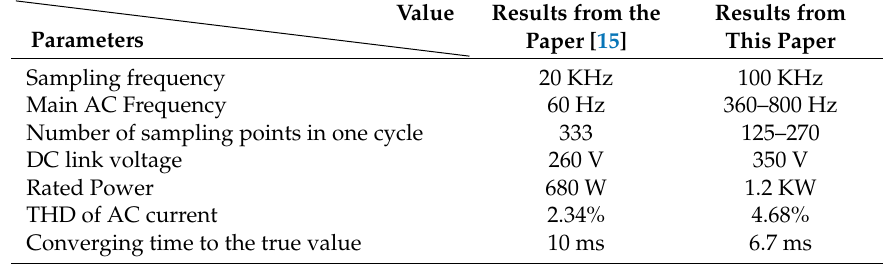
Table 3. Results and parameters forModel Predictive Direct Power Control (MPDPC) with Bayesian